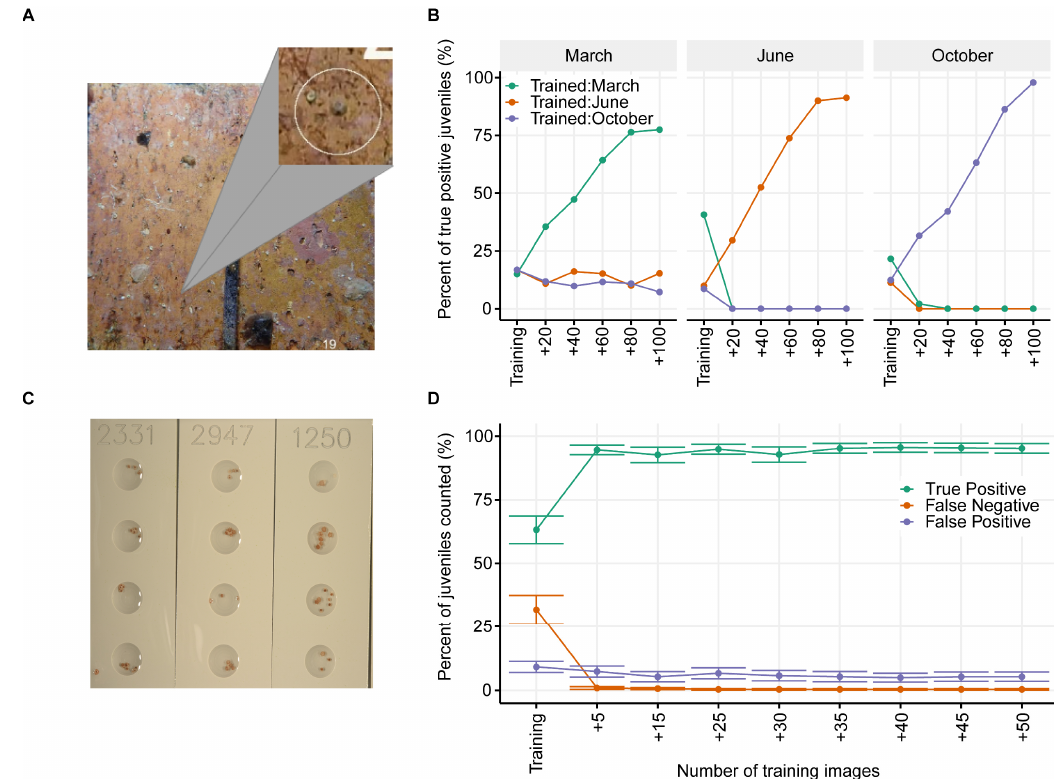
Figure 3. Assessment of machine learning image analysis pipeline for coral juvenile survival. Image showing an example of a field deployed tile with a juvenile highlighted in the inset. Juveniles were cropped to use as training images and test images ( A ). Percentage of juveniles counted correctly as alive (True Positive Rate-TPR) by the pipeline when using the tile images. Facet indicates the time point (month) that the test images were measured from, and color indicates the month the training images were from ( B ). Image showing three plastic PVC slides with settled coral juveniles in each well ( C ). Average percentage ± standard deviation of juveniles correctly counted as alive (true positives), false positives, and false negatives per slide for different sets of numbers of training images ( D ).